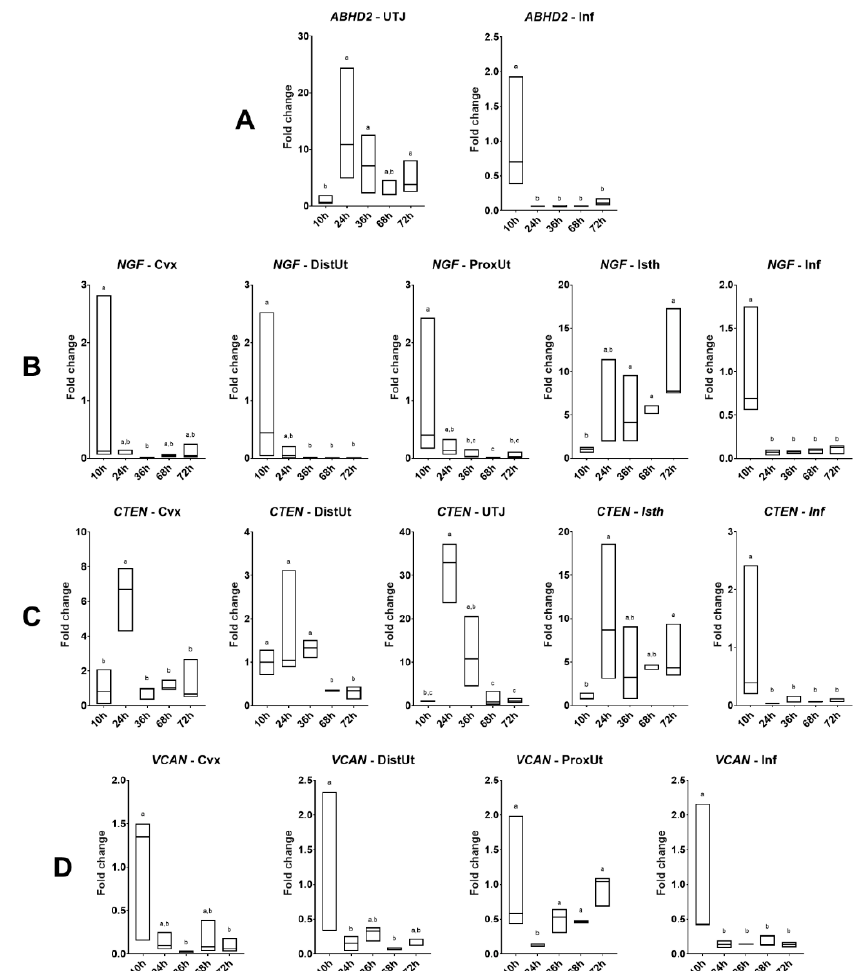
Figure 3. Results of Experiment 2. Gene expression of ( A ) ABHD2 , ( B ) NGF , ( C ) CTEN , and ( D ) VCAN